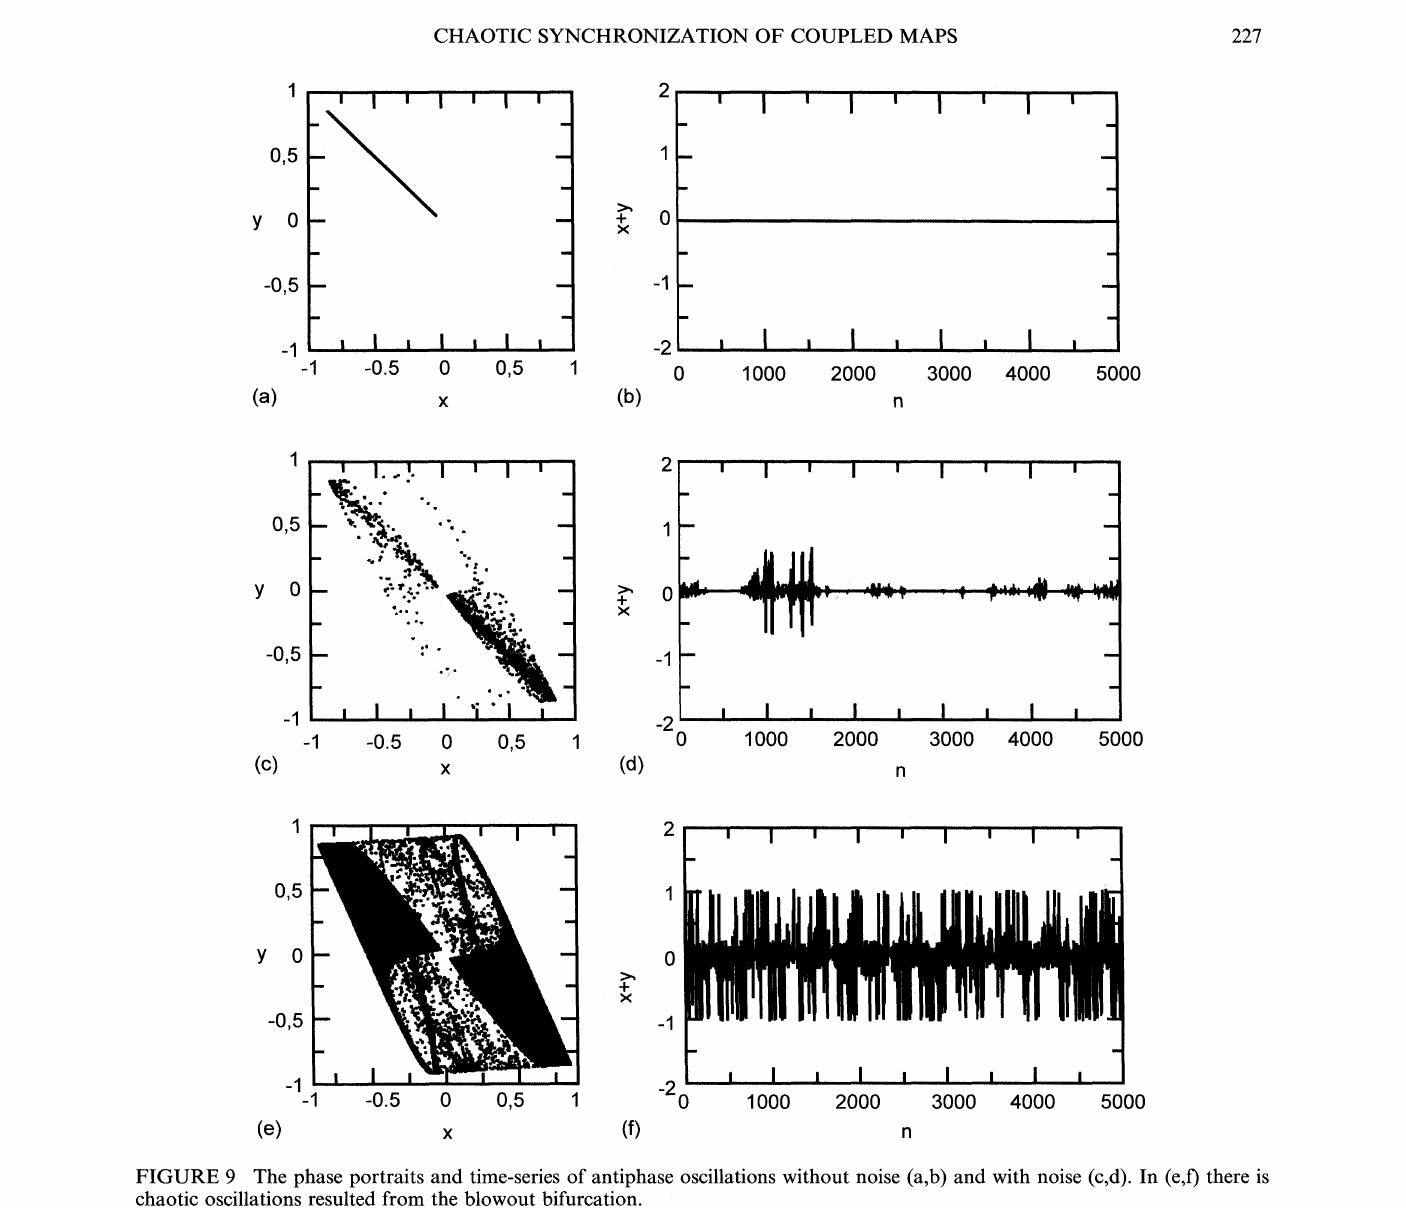
the on-off intermittency process (Platt, 1993).